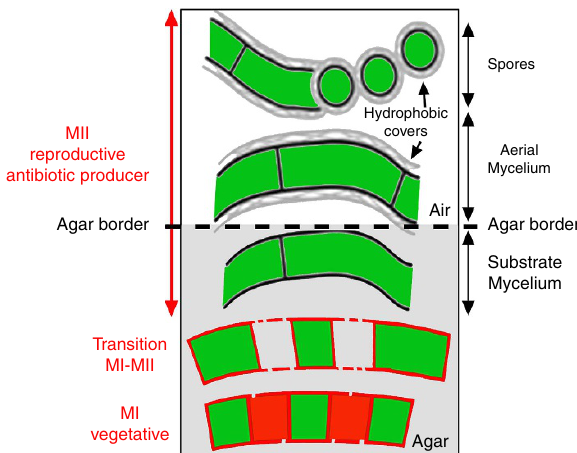
Figure 1 | Development of Streptomyces on solid agar plates. The Streptomyces developmental cycle 3–8 along the transverse axis of the plate is illustrated (the agar border is indicated with a dashed line). Discontinuities in hyphal membranes represent changes in membrane permeability in dying cells. Red and green colours represent PI fluorescence (dying cells) and SYTO9 fluorescence (live cells), respectively. The traditional nomenclature for substrate and aerial mycelia is indicated in black letters (right); the new nomenclature for MI and MII stages is indicated in red letters